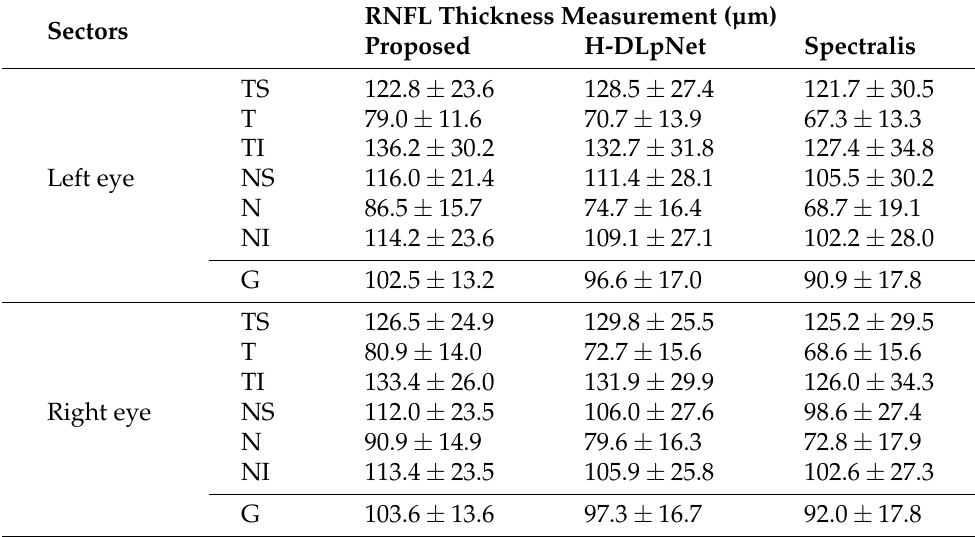
Table 4. RNFL thickness (mean and standard deviation in µm) provided by the proposed method, the H-DLpNet method and Spectralis for each sector of the eye (TS, T, TI, NS, N, and NI) as well as for the whole layer